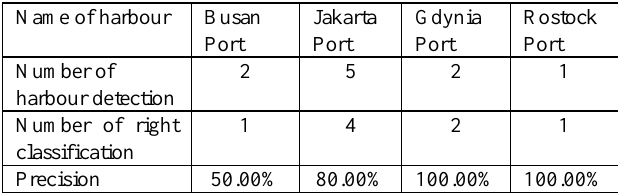
Table 4. Precision for ROI classification on each image by SIFT-based keypoint matching method